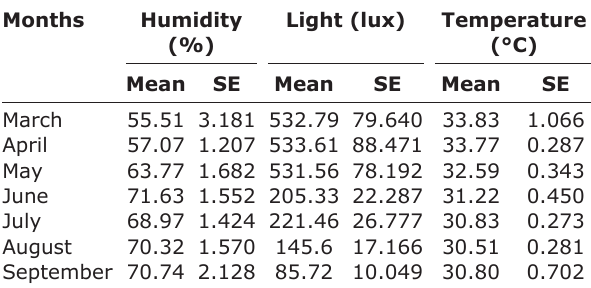
Table-2: Average monthly temperature, light, and humidity in barn during the trial period.